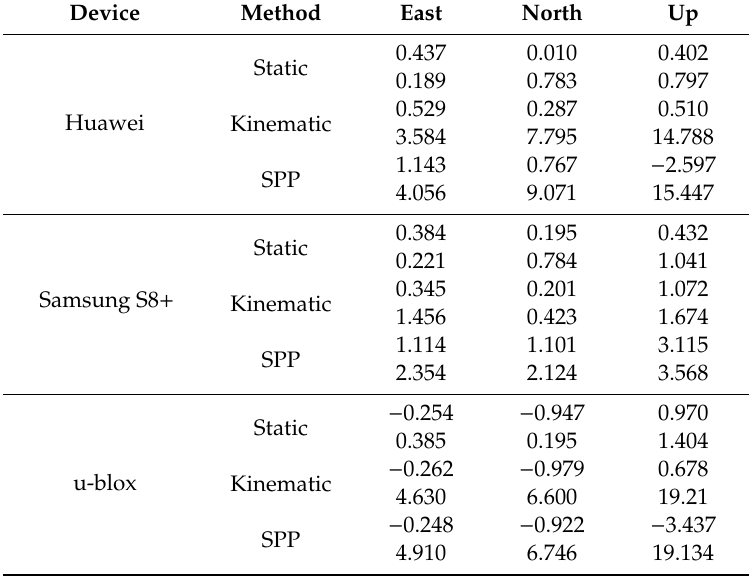
Table 10. Accuracy (upper line for each method) and precision (lower line for each method) results considering a session length of 10 min. All results exceeding a threshold of 3 m are highlighted inside the